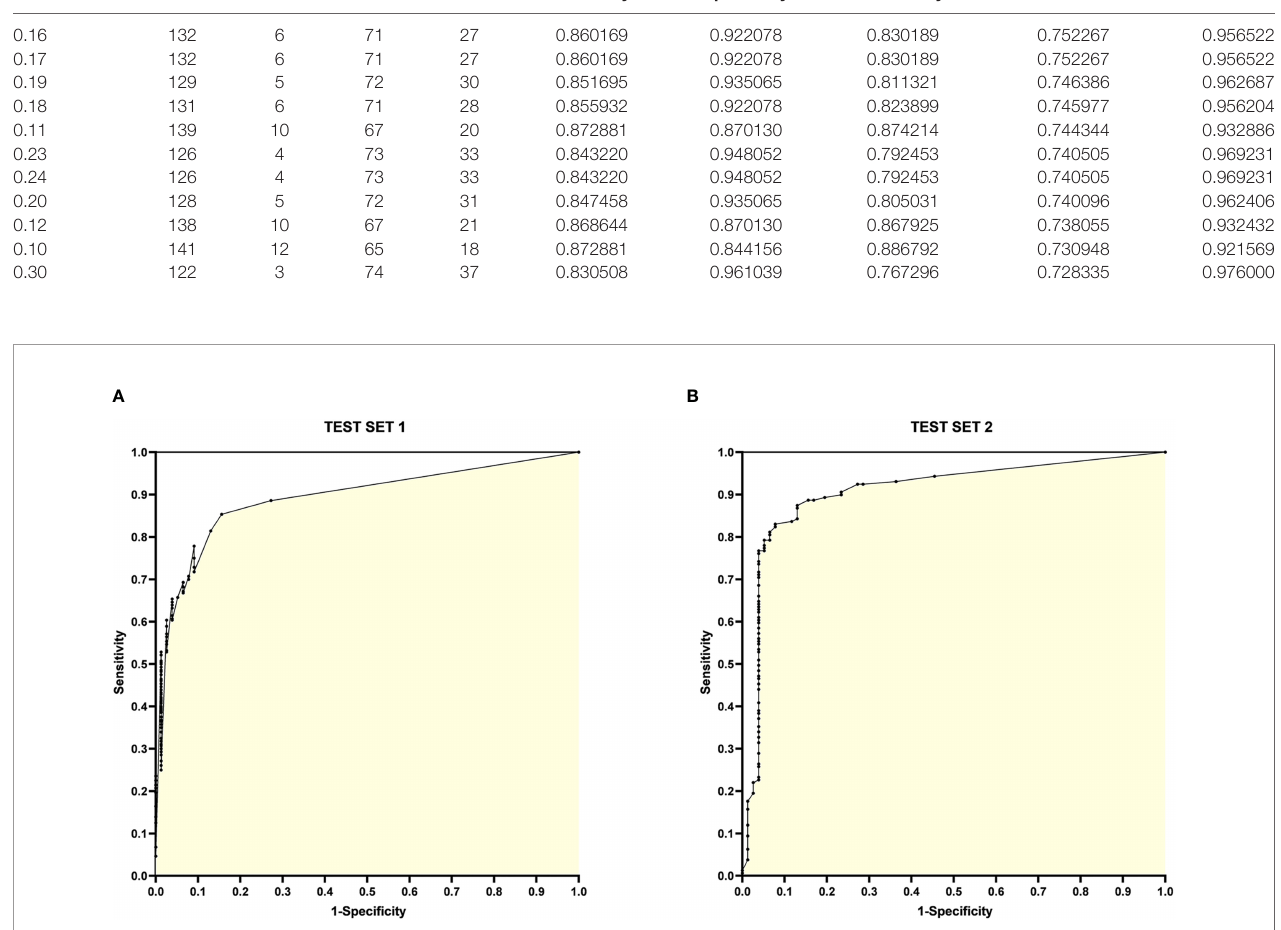
TABLE 3 | The results of Test Set 2 showing the top 10 data in descending order of the Youden Index, with a Threshold-value range of 0.01 to 0.99 and a total of 99 values. Threshold